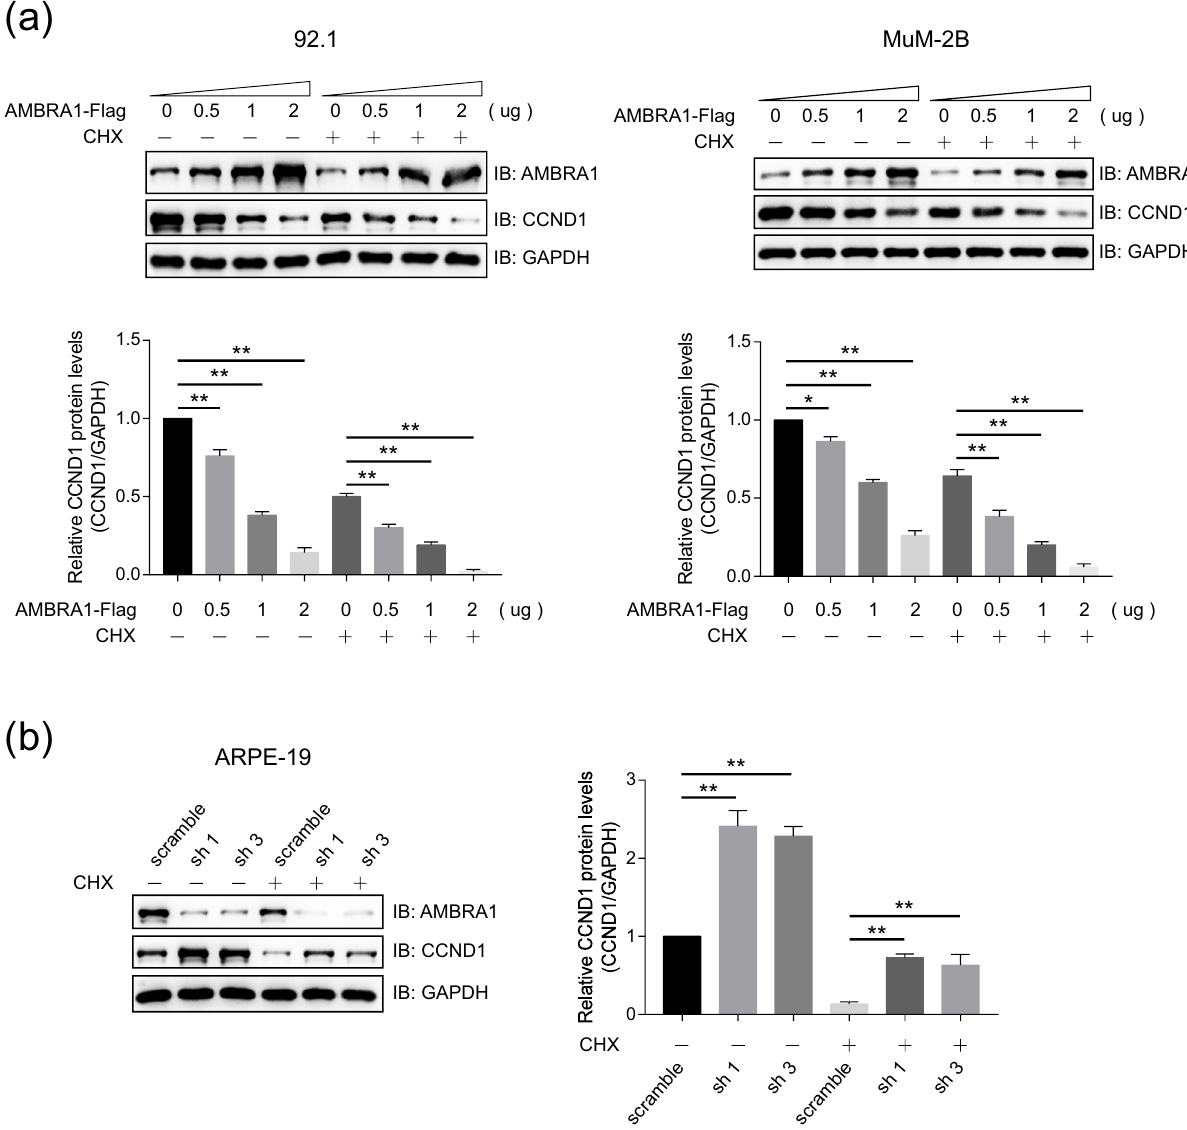
Figure 4: AMBRA1 reduces the stability of CCND1 protein. ( a ) AMBRA1 promoted the degradation of CCND1 in a dose - dependent manner. MUM - 2B and 92.1 cells that were transiently transfected with di ff erent amounts of pCDNA3.0 - AMBRA1 - Flag or empty vectors, treated with or without 100 μ g/mL CHX for 6 h, and then were subjected to immunoblotting analysis using indicated antibodies. The bands of CCND1 were quanti fi ed and compared to that of GAPDH. The data are expressed as mean ± SD and were analyzed using one - way ANOVA with Tukey ’ s post hoc test. **P < 0.01, very signi fi cantly di ff erent, and the experiment was repeated thrice. ( b ) The protein levels of CCND1 were upregulated in AMBRA1 - knockdown cells. The protein levels of AMBRA1 and CCND1 were detected by immunoblotting analysis in ARPE - 19 cells that stably express AMBRA1 shRNAs after treatment with or without CHX ( 100 μ g/mL ) for 6 h. The bands of CCND1 were quanti fi ed and compared to that of GAPDH. The data are expressed as mean ± SD and were analyzed using one - way ANOVA with Tukey ’ s post hoc test. **P < 0.05, signi fi cantly di ff erent; **P < 0.01, very signi fi cantly di ff erent, the experiment was repeated